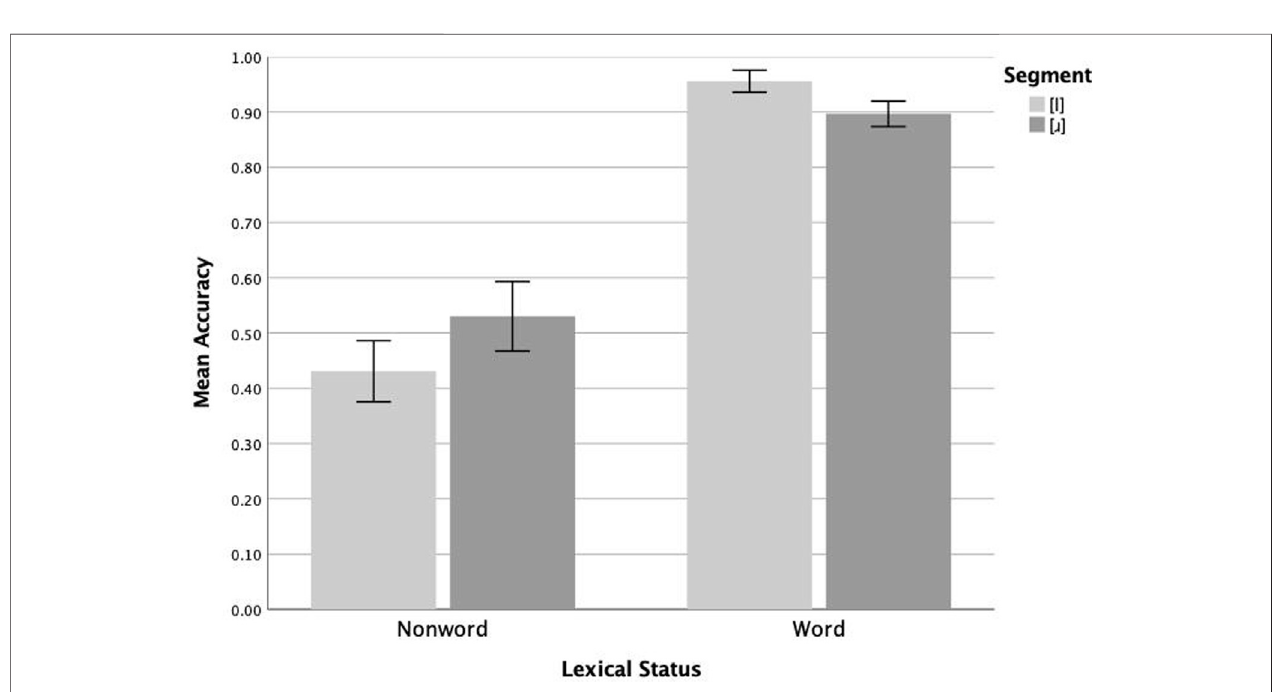
Frontiers in Communication |